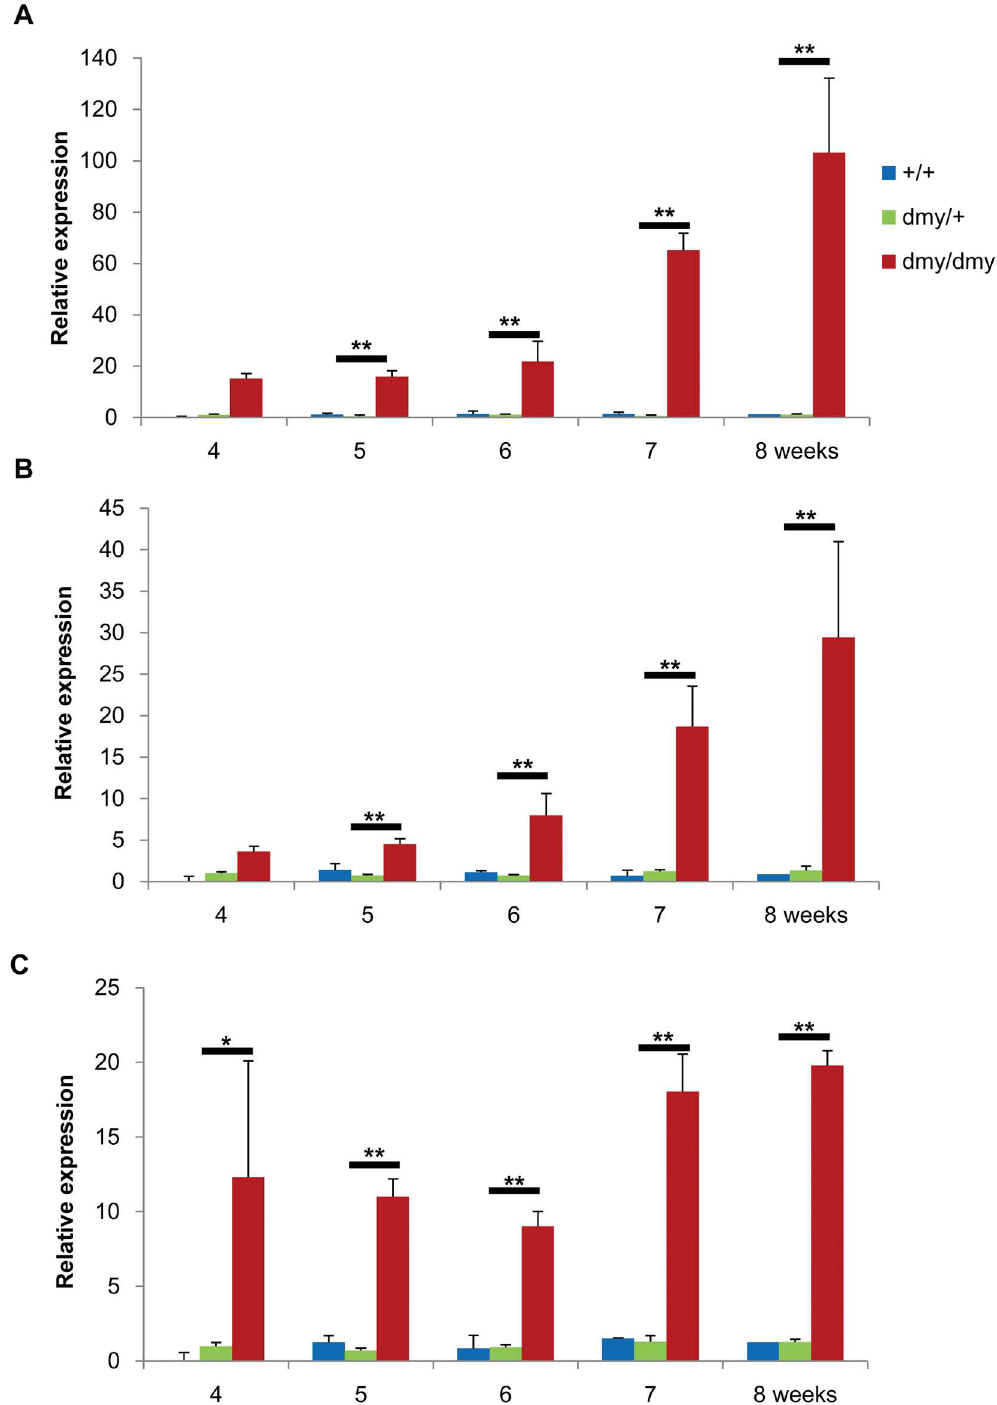
Fig 1. Real-time PCR for Trib3 . Expression of Trib3 gene in the ventral funiculusin the dmy rats (A), gray matter (B) and dorsal funiculus(C) of the cervical spinal cords from the control (+/+ and dmy /+) and the dmy ( dmy / dmy ) rats. The data are presentedas the mean ratio of target to reference gene. β -actin is used as an internalcontrol. In the dmy rats, expressionlevels of Trib3 mRNA is significantly increasedin all areas at 4, 5, 6, 7 and 8 weeks of age. * , p < 0.05, ** , p < 0.01, Tukey-Kramer test ( n = 3 in each group).